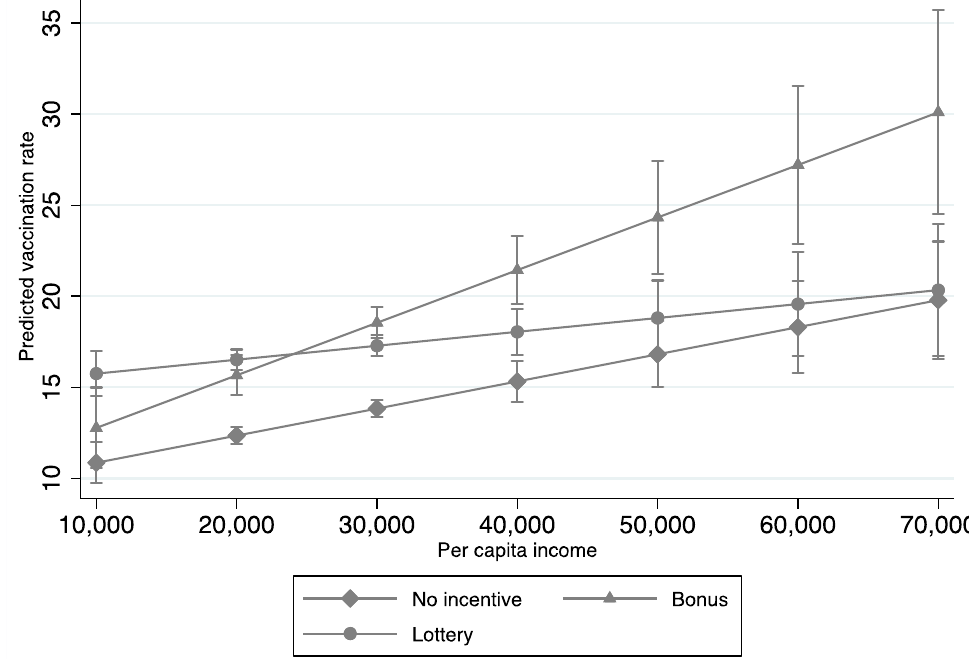
Figure 1. Interaction effects of COVID-19 vaccination incentive policies and per capita income (Model 3 in Table 3).